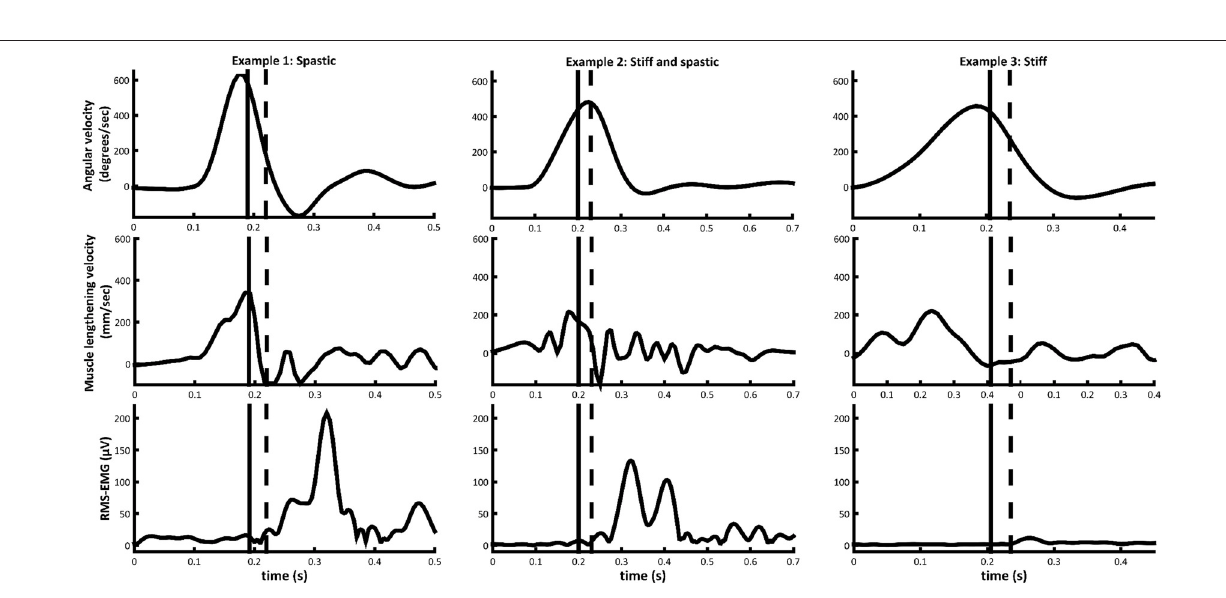
FIGURE 3 | Angular velocity, medial gastrocnemius muscle lengthening velocity, and medial gastrocnemius RMS-EMG during fast passive rotation examples of muscles from three different subjects in the CP group. Timing of EMG-onset (black dashed line) and the stretch reflex threshold 30ms prior to EMG-onset (black vertical line), are